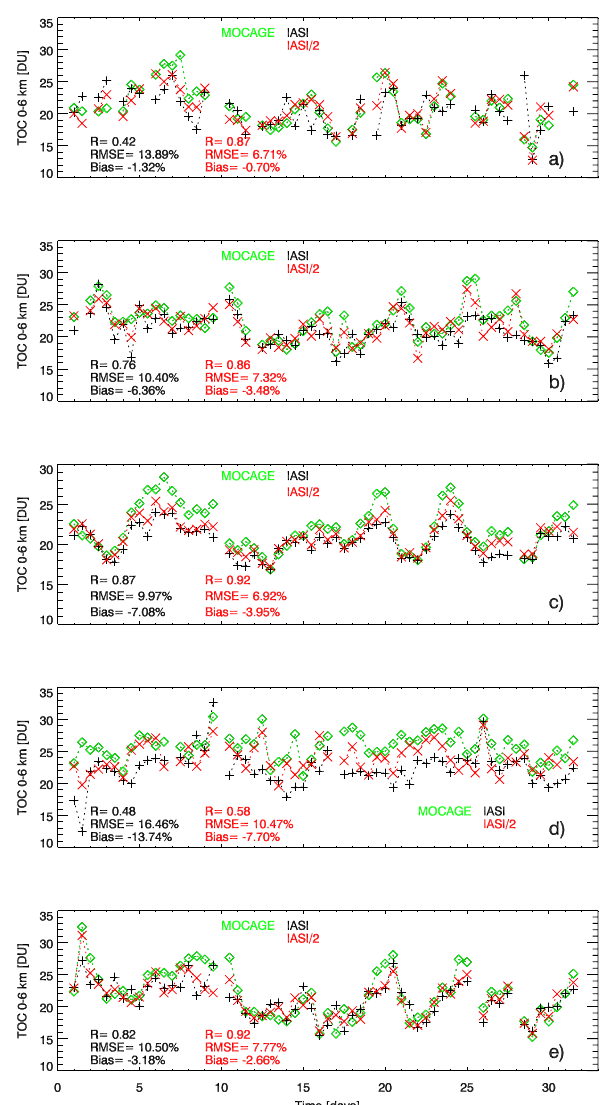
Fig. 11. Time series of MOCAGE pseudo-reality (green), and IASI (black) and IASI/2 pseudo-observations (red) over Amsterdam, the Netherlands (a) ; Berlin, Germany (b) ; Paris, France (c) ; Barcelona, Spain (d) ; a marine location West of Norway, 58.0 ◦ N–5 ◦ E (e) . Mean percent biases, percent RMSEs and Pearson coefficients are also reported for the two instruments.